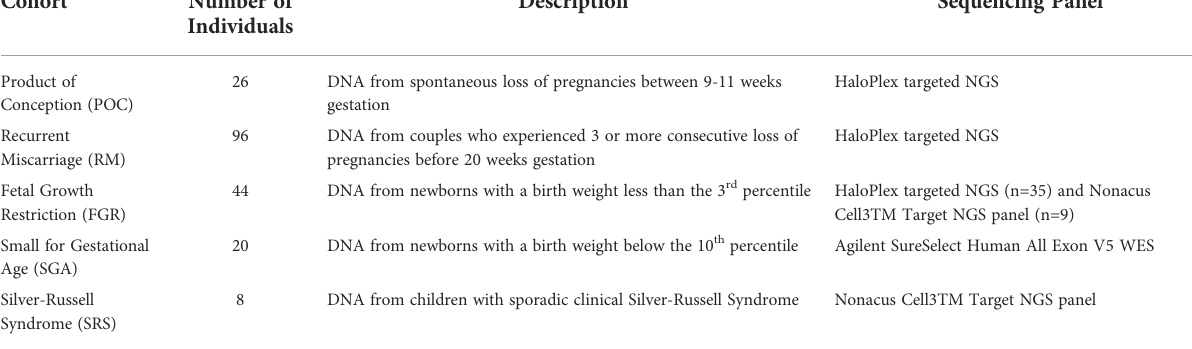
TABLE 1 Overview of the cohorts